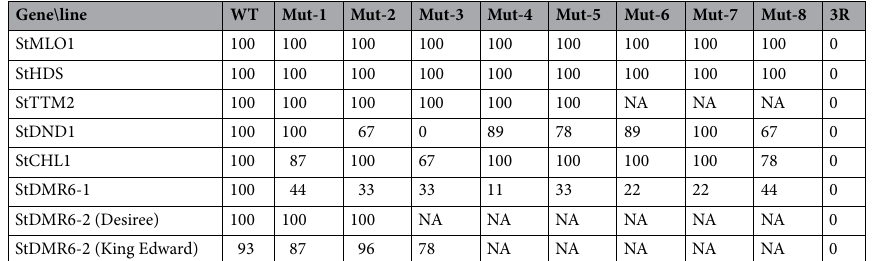
Table 3. Percent of successfully infected leaflets in detached-leaf assay. Mut-1 to Mut-8 are mutant lines and correspond to the lines in Fig. 1 (from left to right). Leaflets from 5-week-old plants were inoculated with